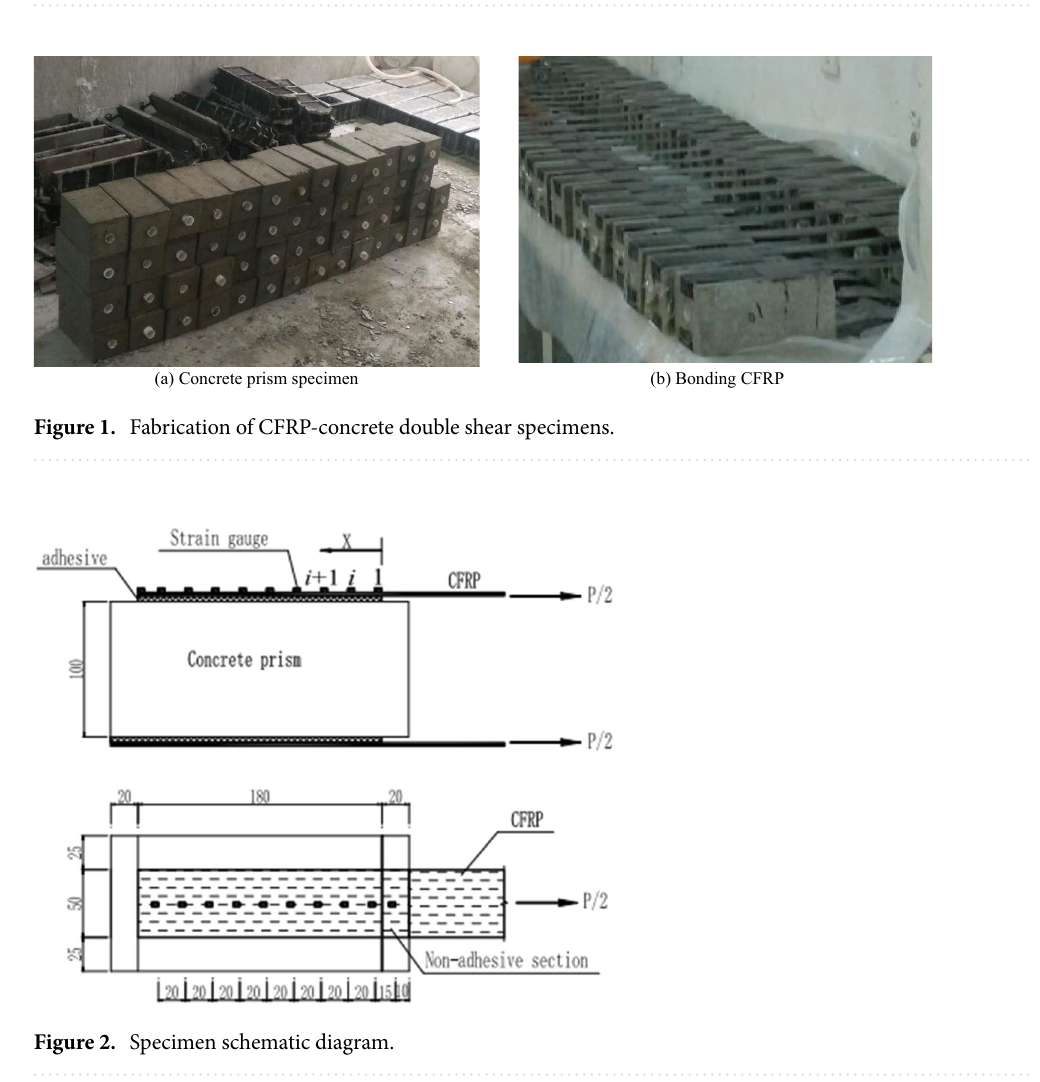
Table 4. Concrete mix ratio.